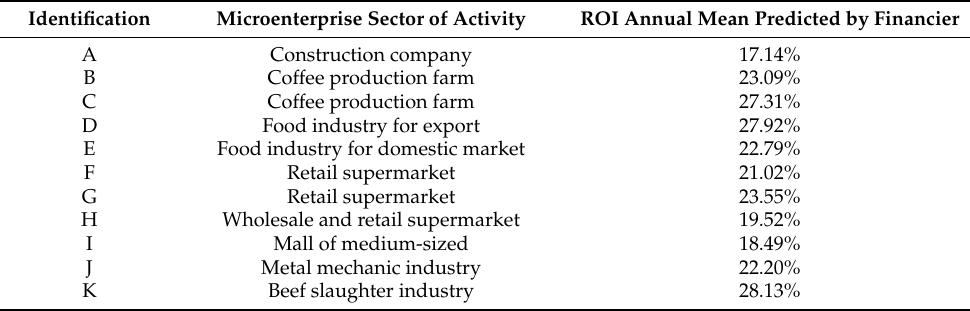
Table 1. Identifications and annual ROI